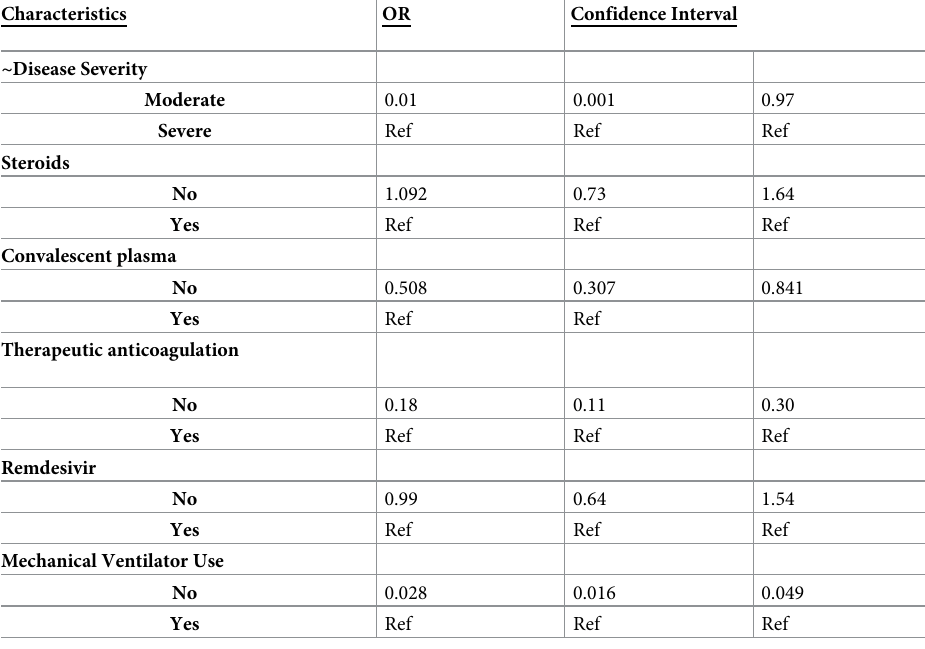
Table 2. Unadjusted OR of disease severity/interventions and mortality.